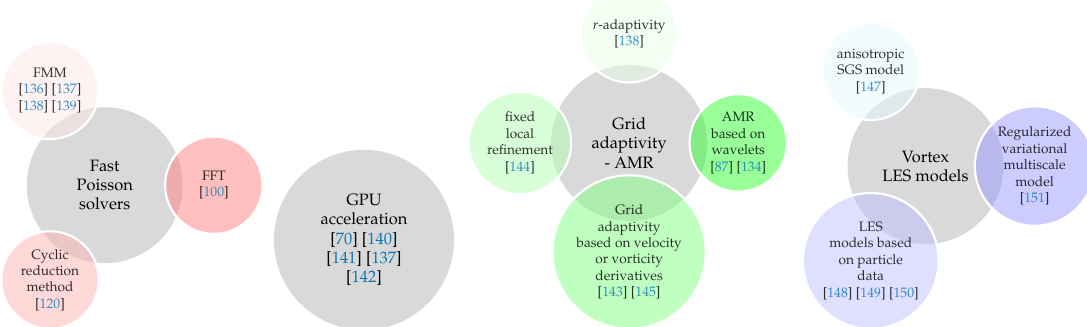
Figure 10. Algorithm issues in Vortex methods: summarize-diagram of Section